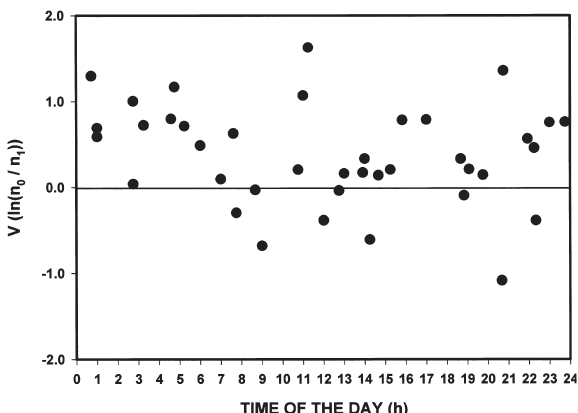
F IG . 9. – The vertical distribution parameter (V) as a function of time of the day of Euphausia mucronata . V was estimated from abundance of individuals (No. m -3 ) in the upper 50 m layer and in the deep layer 50-200 m. During daytime, between 6:00 AM